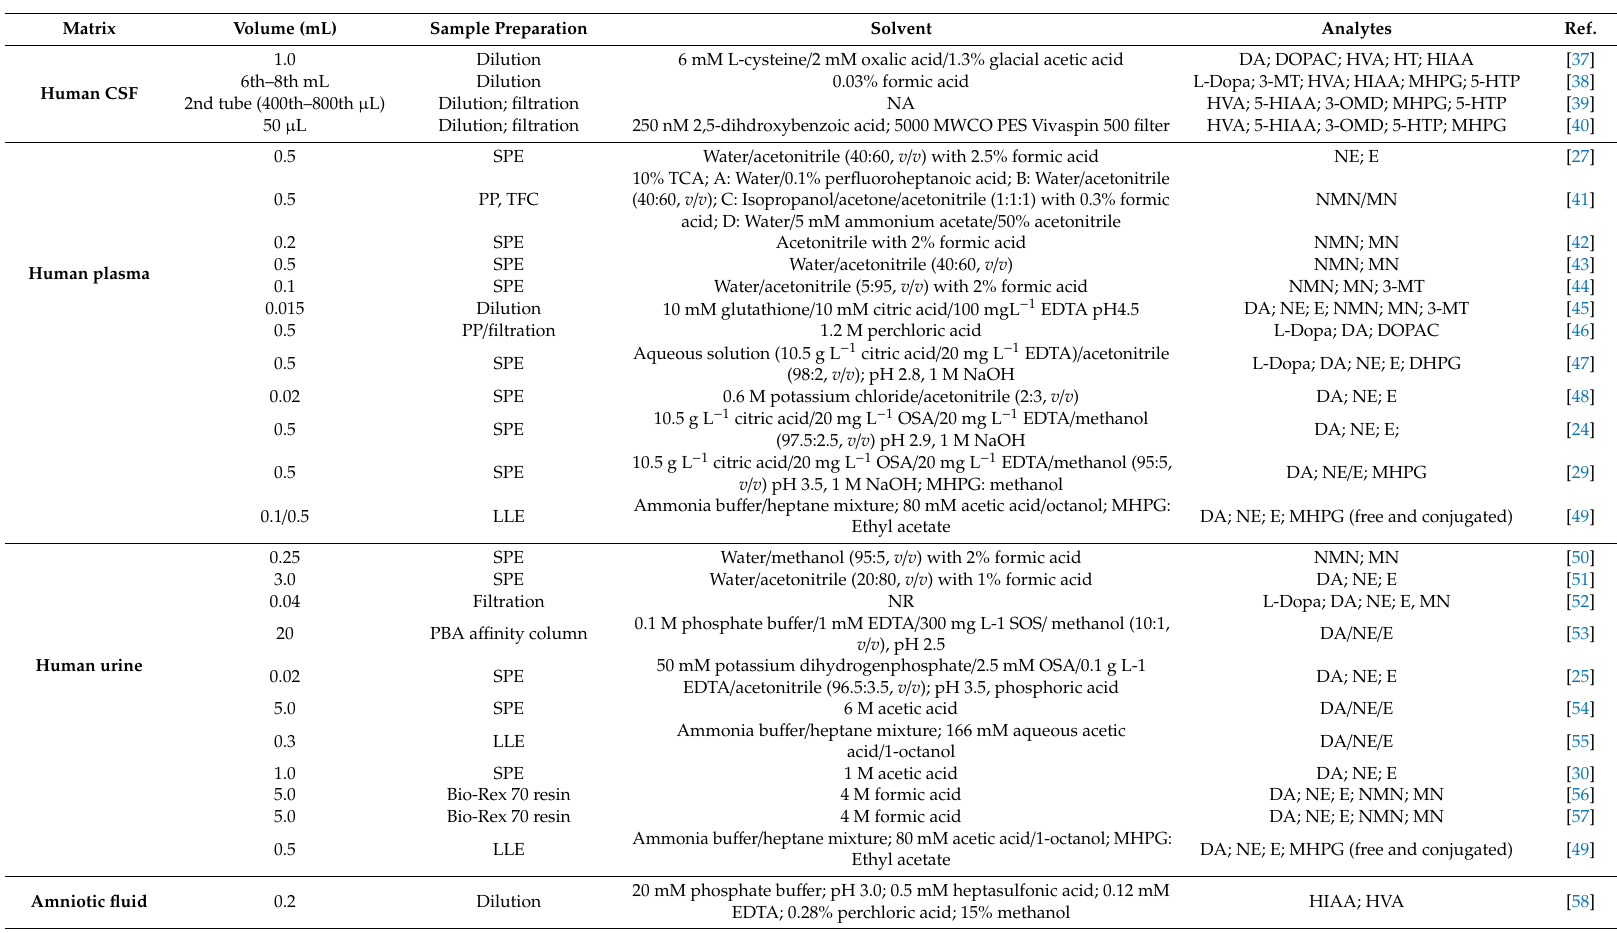
Table 1. Sample pre-treatment for the quantification of catecholamines and some of their metabolites in di ff erent human fluids.